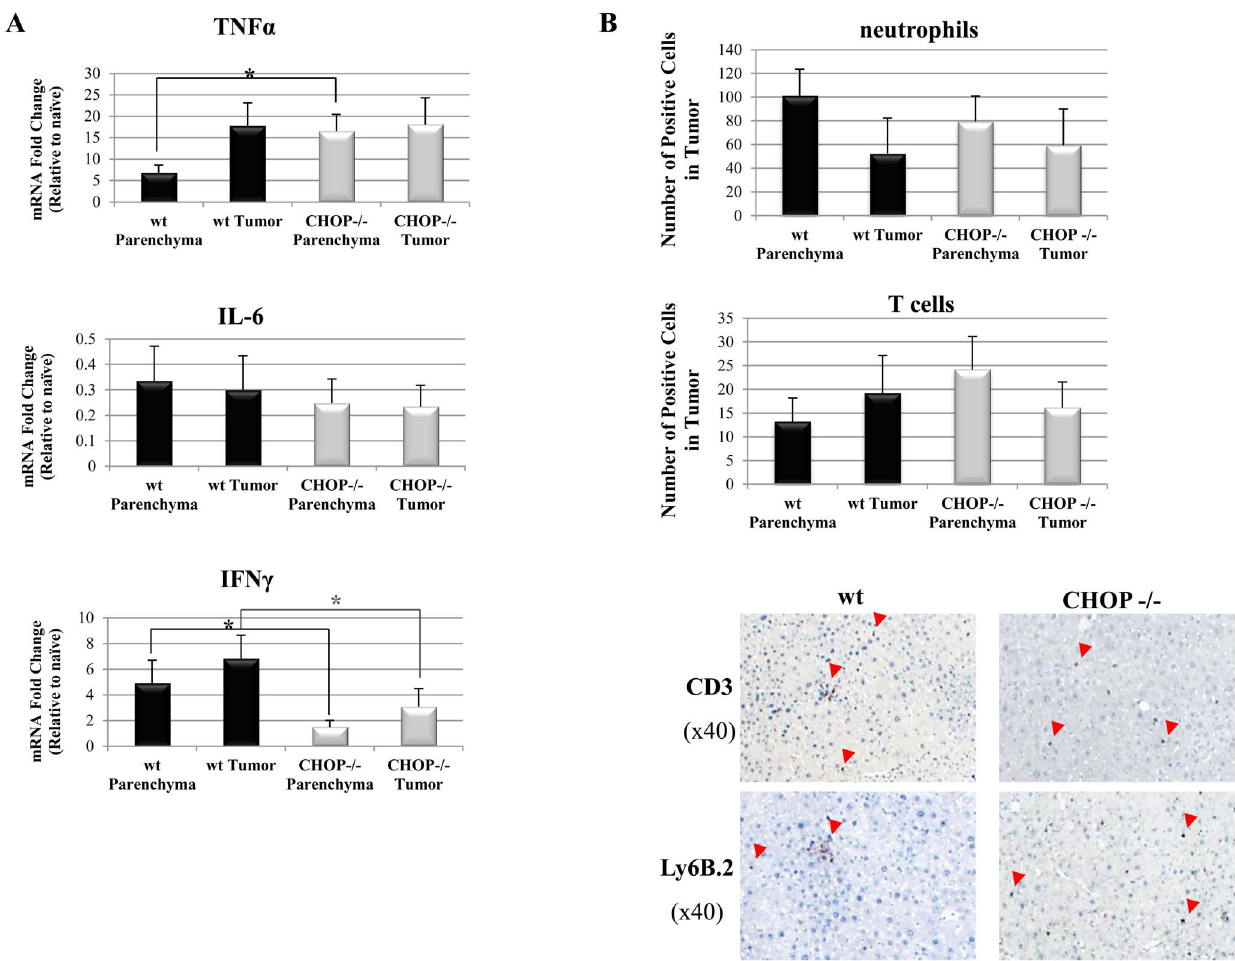
Figure 4. Cytokine levels and immune cell infiltration into DEN-induced HCC. A. Analysis of cytokines mRNA levels in tumor and parenchyma of WT and CHOP 2 / 2 mice (n=5, p , 0.01 for statistical significance). B. Histological sections of liver tissue slides were stained for T cells (anti-CD3) and neutrophils (anti-Ly6B.2). The total number of CD3 or Ly6B.2 positive cells in wt and CHOP 2 / 2 tumor and parenchyma were counted (n=5 for each